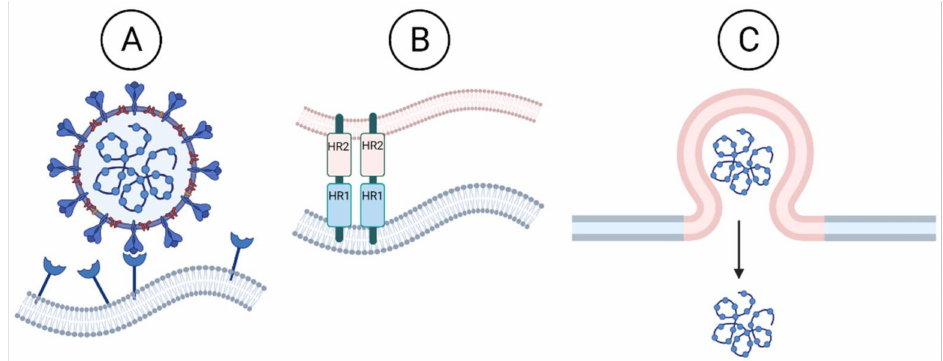
Figure 2. Coronavirus entry. To release the viral RNA genome, the coronavirus must bind to the target host cell, fuse the viral and host membranes, and release the viral genome into the host cytoplasm. ( A ) Coronavirus S protein receptor binding domain (RBD) binds with the host receptor on cell surface. SARS-CoV-2 S protein binds host ACE2. ( B ) S protein binding with host receptor exposes the S protein heptad repeat (HR) domains for fusion. HR1 and HR2 domains pull the cell and viral membranes together to fuse. ( C ) Fusion results in release of viral genome into the host cell cytoplasm. Created with